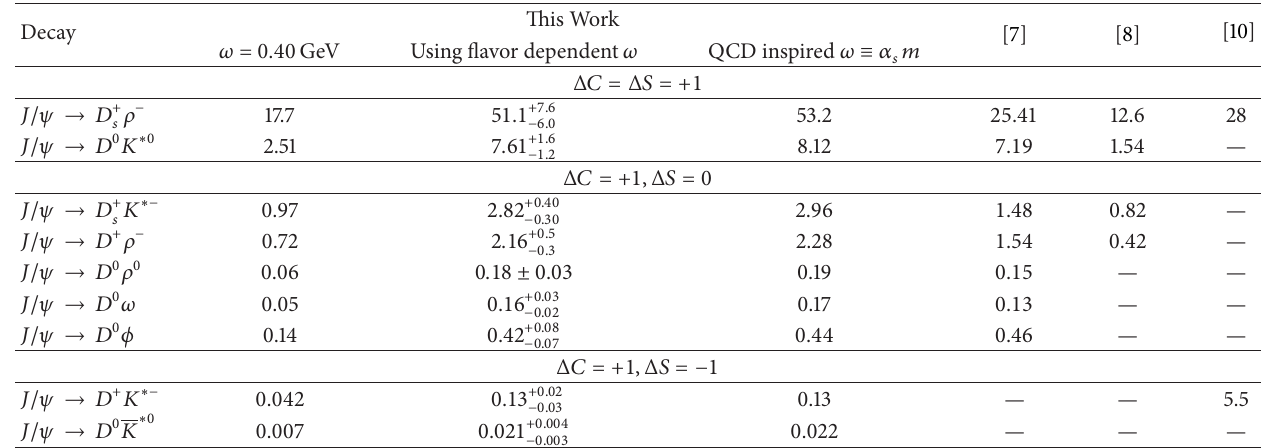
Table 5: Branching Ratios (in the units of 10 −10 ) of 𝐽/𝜓 → 𝑃𝑉